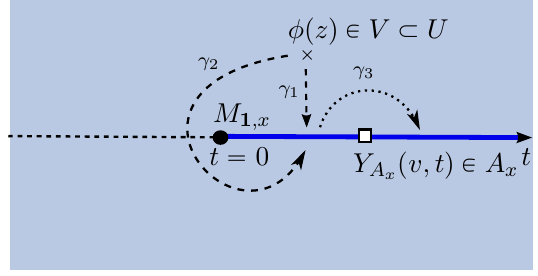
Figure 6 . This picture depicts how the chiral (cid:12)elds in U can be mapped to A x . 1. (cid:19) (cid:19) ; (cid:13) 1 | V (cid:16) (cid:13) 2 | V 2. (cid:19) : V (cid:209) A is (cid:13) 1 | V x